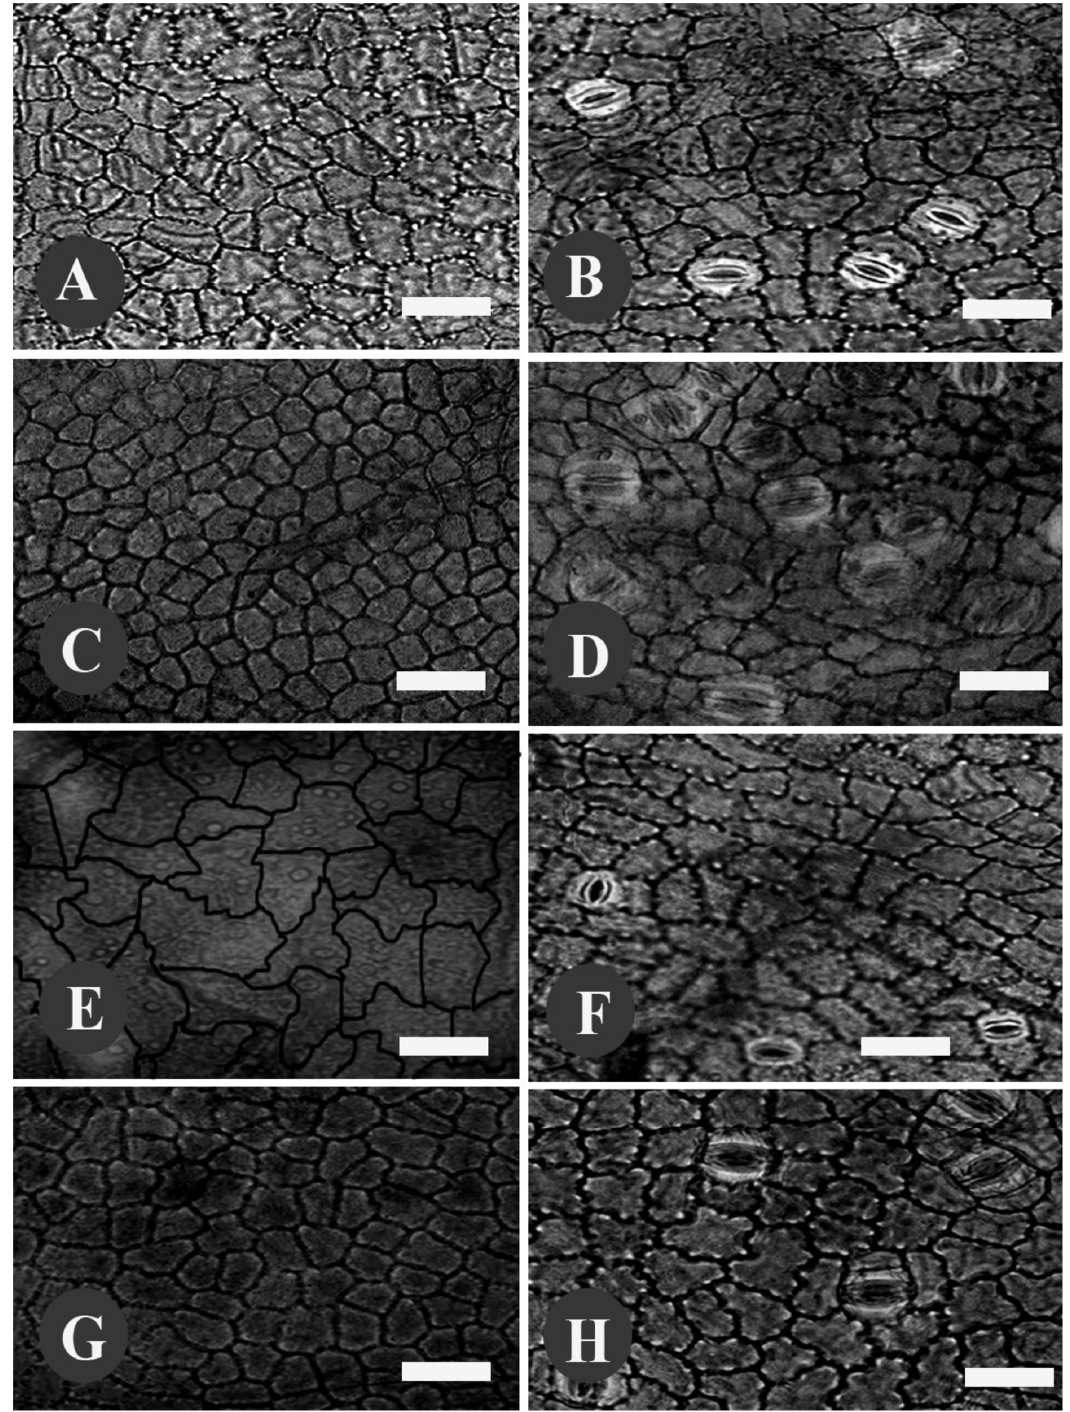
Figure 1. Comparative characters of leaf epidermis of the species of Isolona A, C, E and G: Adaxial surfaces- B, D, F and H: Abaxial surfaces- A, B- Isolona campanulata, C, D- I. congolana. E, F- I. dewevrei G, H- I. hexaloba Scale bar- 25